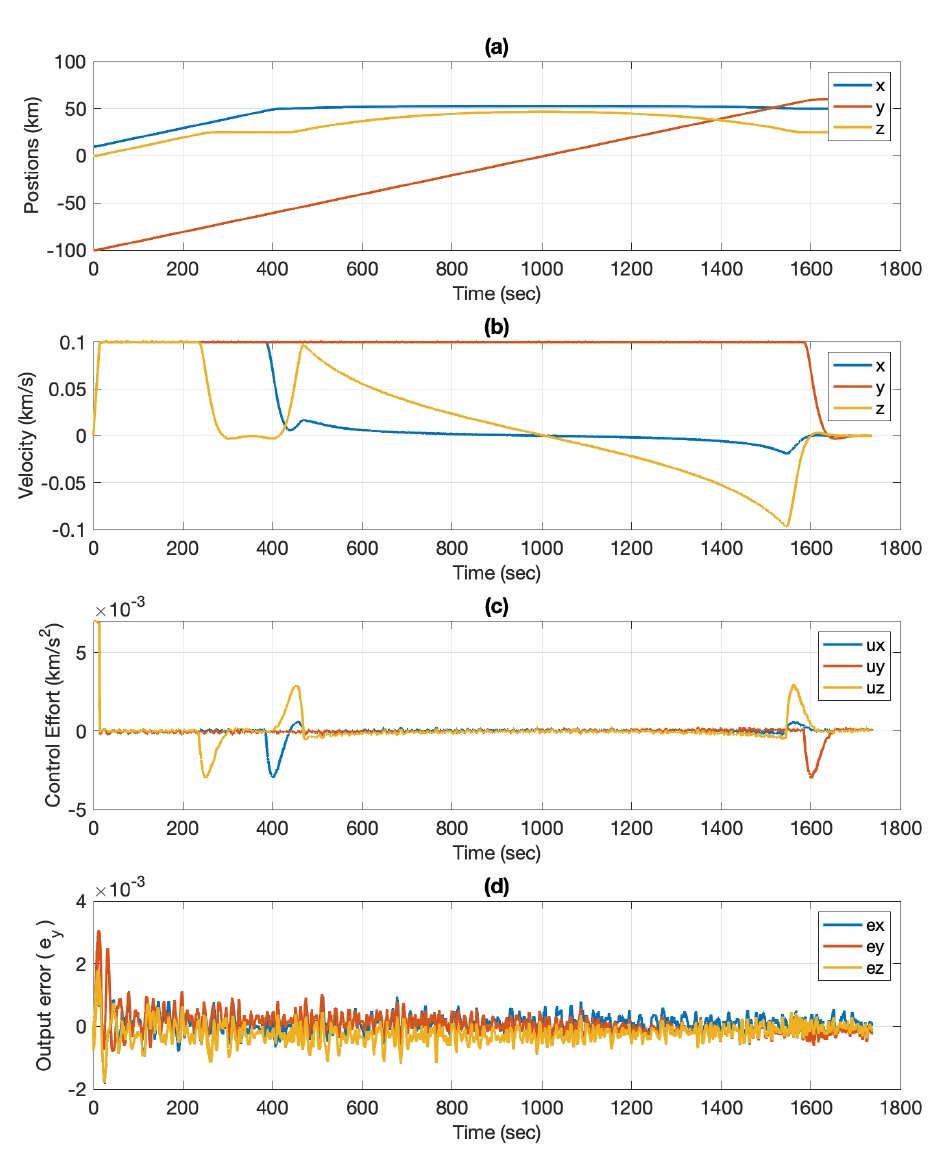
Figure 13. Plots for DAMPC case with noise for asteroid Kleopatra: ( a ) position vs. time; ( b ) velocity vs. time; ( c ) control effort vs. time; ( d ) output error vs. time.